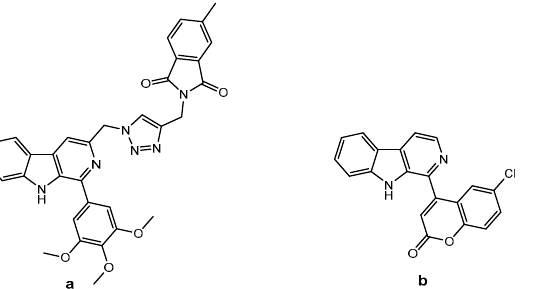
Figure 1. β -carboline hybrids with anticancer activity: ( a ) β -carboline–triazole hybrid (IC 50 = 3.67 and 5.44 µ M against HT-29 and HGC-27) [16], ( b ) coumarin– β -carboline hybrid (GI 50 = 67.5 µ M against HeLa) [23].